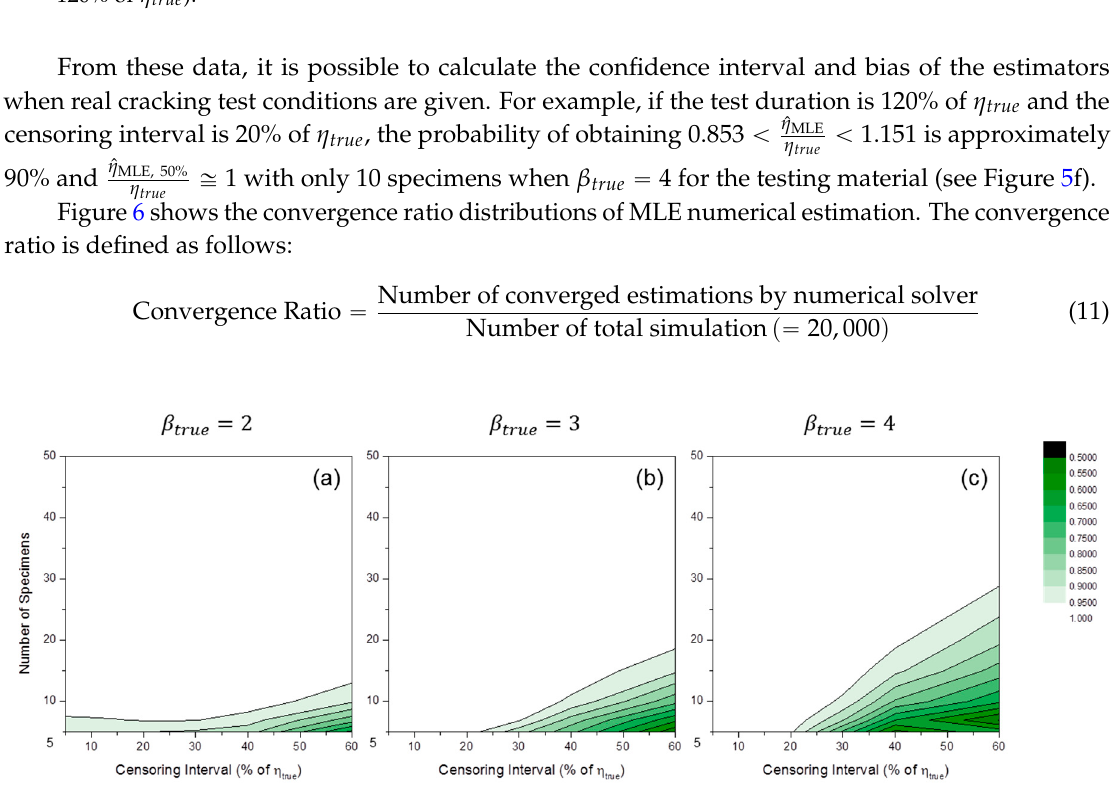
Figure 5. Effect of specimens number on SE((cid:2010)(cid:4632)) at: ( a ) (cid:2010) (cid:3047)(cid:3045)(cid:3048)(cid:3032) = 2 ; ( b ) (cid:2010) (cid:3047)(cid:3045)(cid:3048)(cid:3032) = 3 ; and ( c ) (cid:2010) (cid:3047)(cid:3045)(cid:3048)(cid:3032) = 4 ; and on SE((cid:2015)̂) at: ( d ) (cid:2010) (cid:3047)(cid:3045)(cid:3048)(cid:3032) = 2 ; ( e ) (cid:2010) (cid:3047)(cid:3045)(cid:3048)(cid:3032) = 3 ; and ( f ) (cid:2010) (cid:3047)(cid:3045)(cid:3048)(cid:3032) = 4 (censoring interval: 20% of (cid:2015) (cid:3047)(cid:3045)(cid:3048)(cid:3032) ; test duration: 120% of (cid:2015) (cid:3047)(cid:3045)(cid:3048)(cid:3032) ).